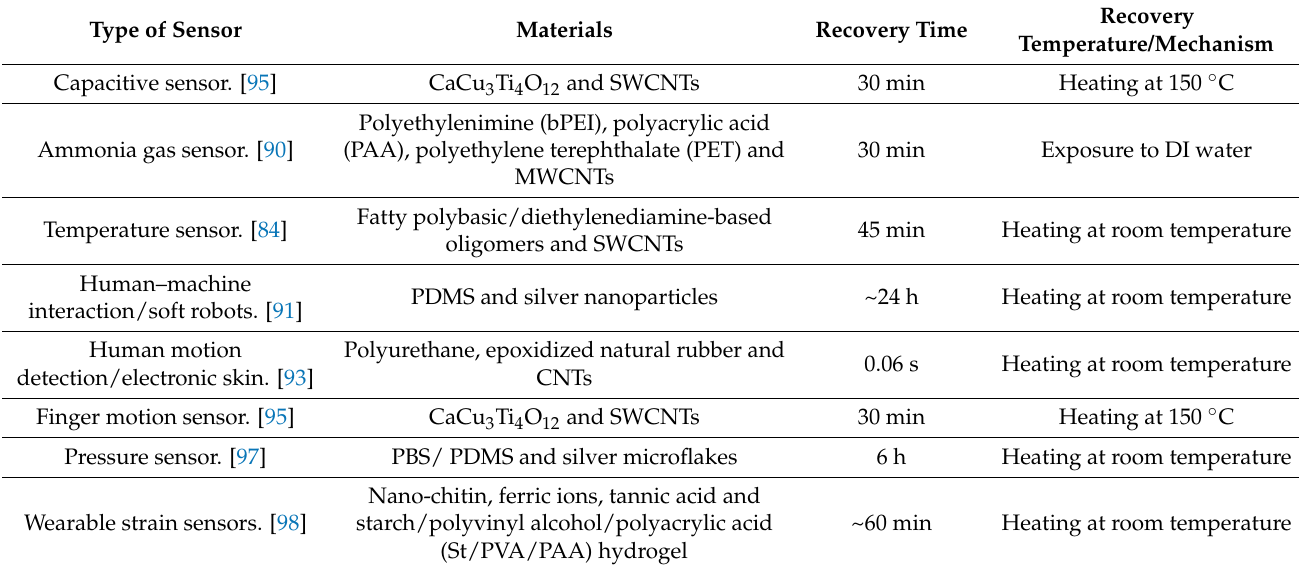
Table 4. Examples of self-healing sensors and some key characteristics studied in